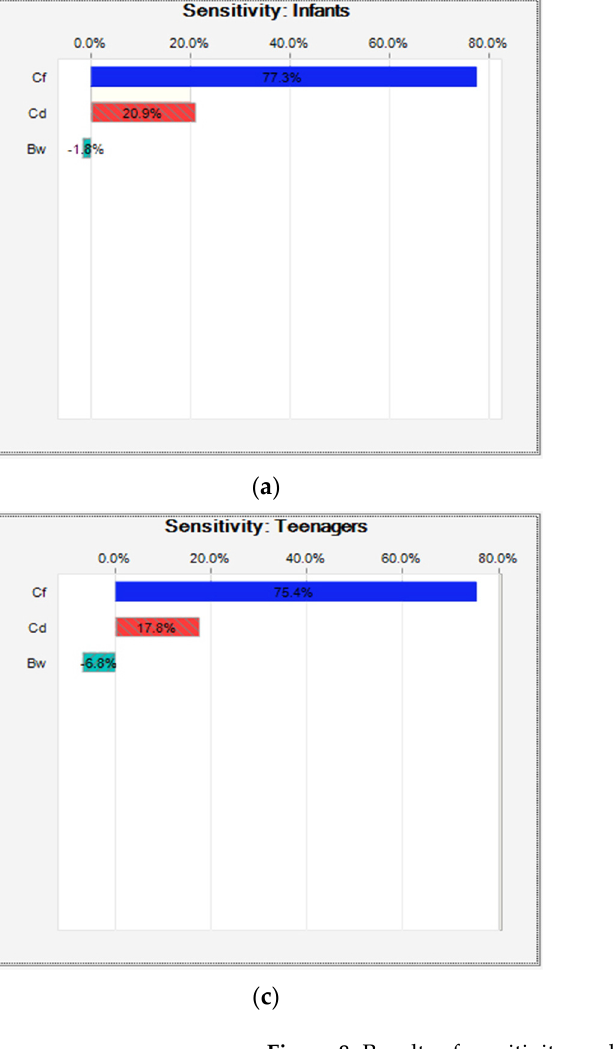
Figure 8. Results of sensitivity analysis: ( a ) Infants; ( b ) Children; ( c ) Teenagers; ( d )